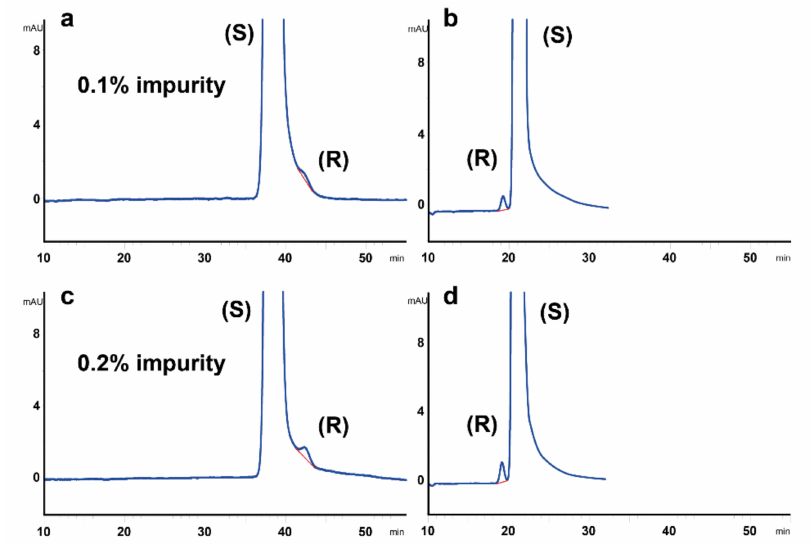
Figure 5. The chromatograms of two commercially available dexketoprofen 25 mg / mL injectable solutions with methods using either Lux i-Amylose-3 (250 × 4.6 mm, 5 µ m) ( a , c ), or its coated analogue (250 × 4.6, 5 µ m) ( b , d ). Separation temperature was 35 ◦ C, flow rate was 2 mL / min, detection was performed at 254 nm with the mobile phase composition of n-hexane:ethanol:formic acid, 95:5:0.1 ( v / v / v )